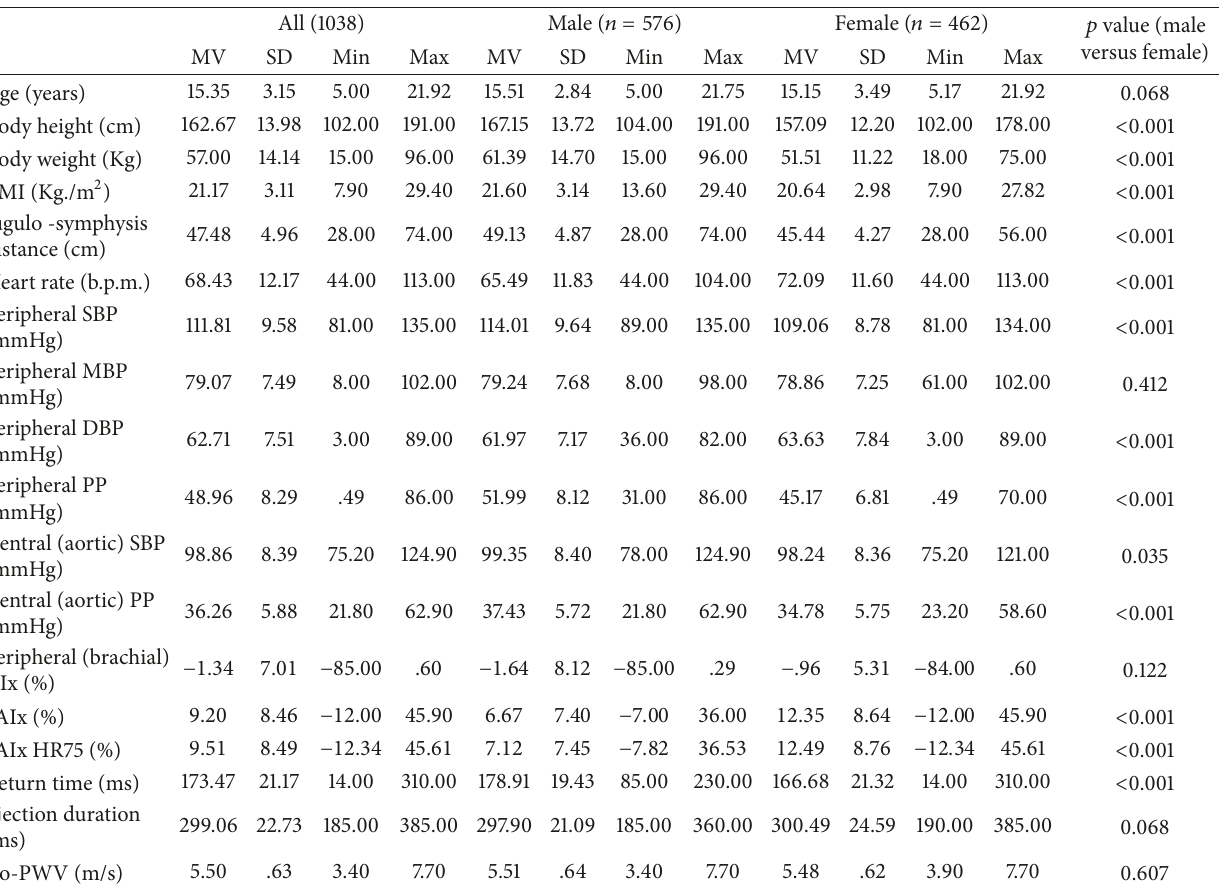
Table 1: Children and adolescents